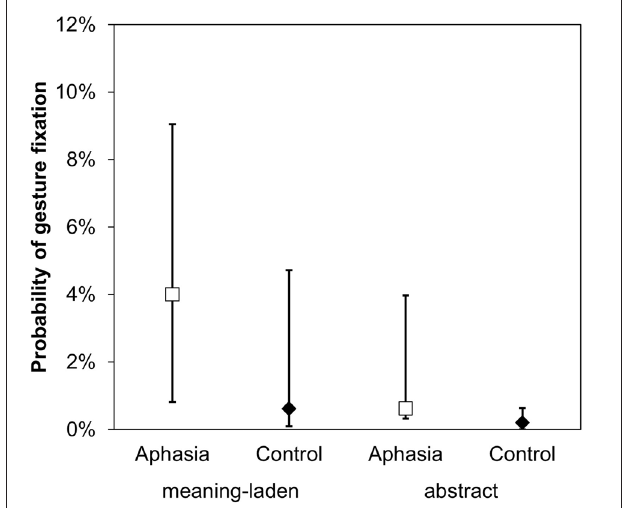
FIGURE 2 | Gesture perception. An illustration of the main effects of gesture category and group on the dependent variables probability of overt gesture fixation. Error bars represent the 95% confidence intervals around the estimated